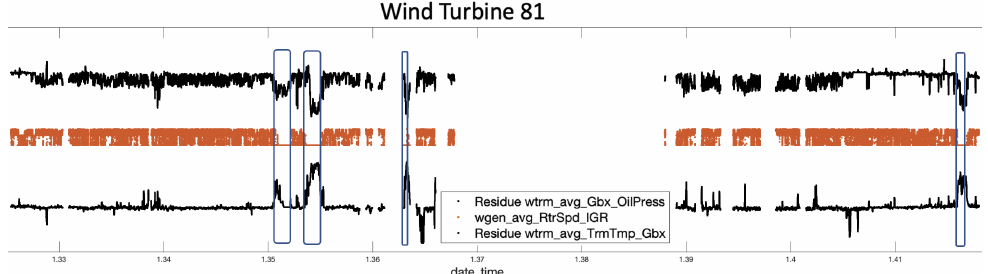
Figure 13. Analysis of the WT80 turbine on the basis of the residues obtained from the signals wtrm_avg_Gbx_OilPress (upper signal, in black) and wtrm_avg_TrmTmp_Gbx (lower signal, in black) together with the rotation of the rotor of the WT80 turbine (central part, in blue). The blue rectangles identify peaks in the residual signals that coincide with the turbine stops, detected as zero-valued angular velocities. The red rectangle shows a ghost peak.